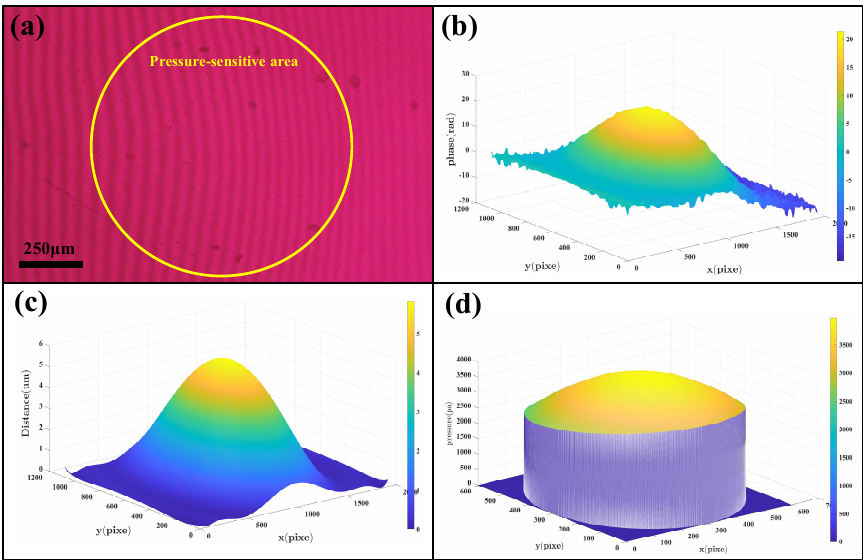
Figure 4. ( a ) Interference pattern at 22.5 mmHg. ( b ) Phase diagram of Interference pattern. ( c ) 3D model of the membrane. ( d ) The distribution diagram of pressure on the membrane.